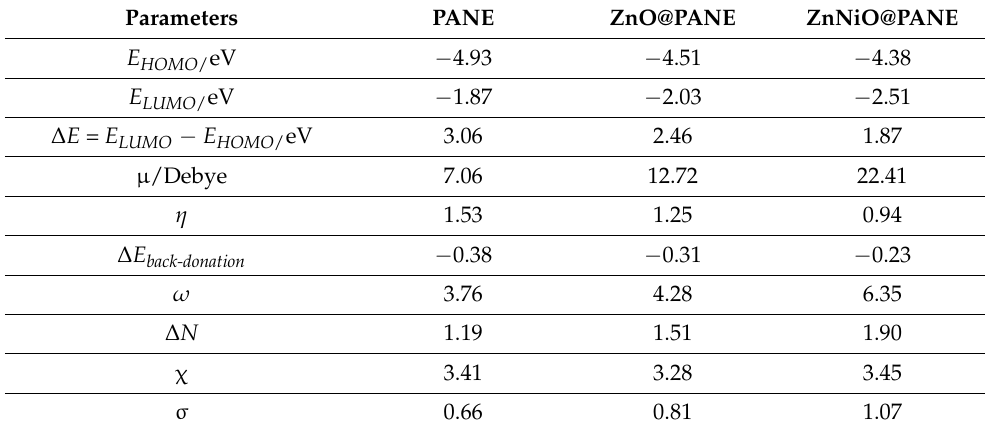
Figure 9. The DFT optimized structure and the occupation of the LUMO and HOMO orbitals for the PANE, ZnO@PANE, and ZnNiO@PANE compounds. Table 3. DFT parameters of the studied compounds.